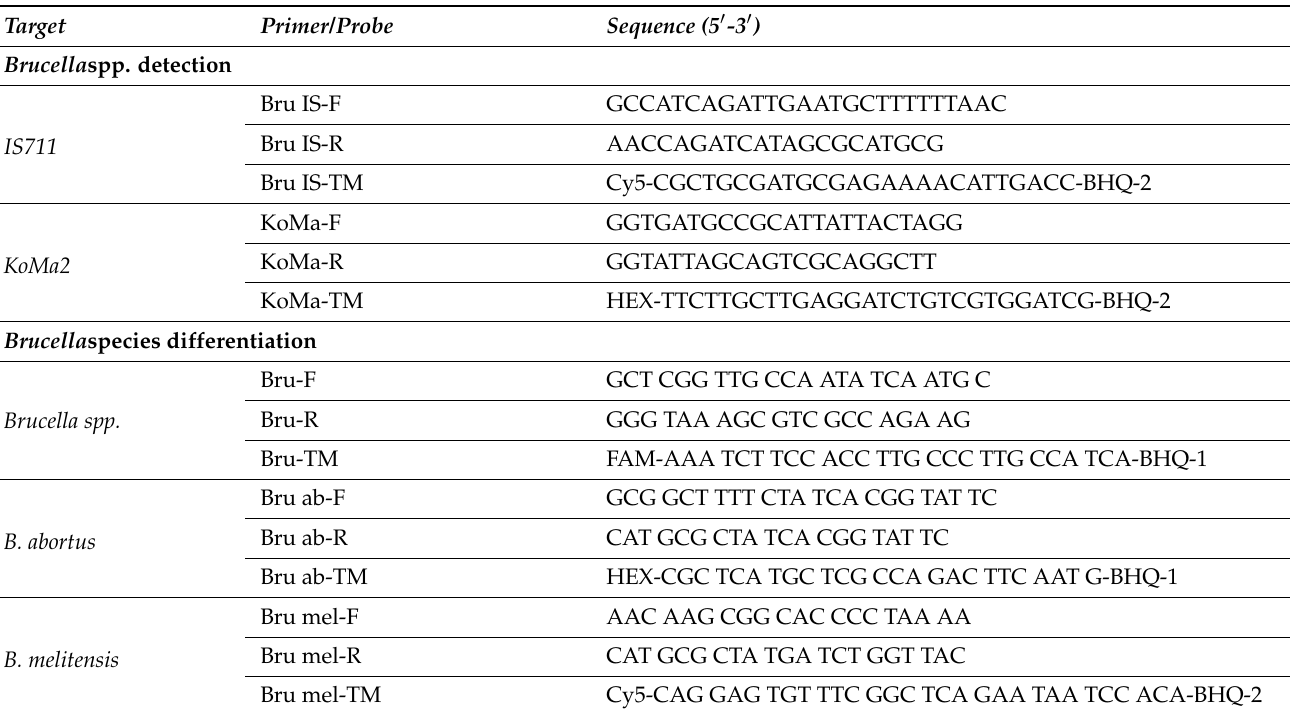
Table 1. qPCR primers and probes for Brucella spp. detection and species